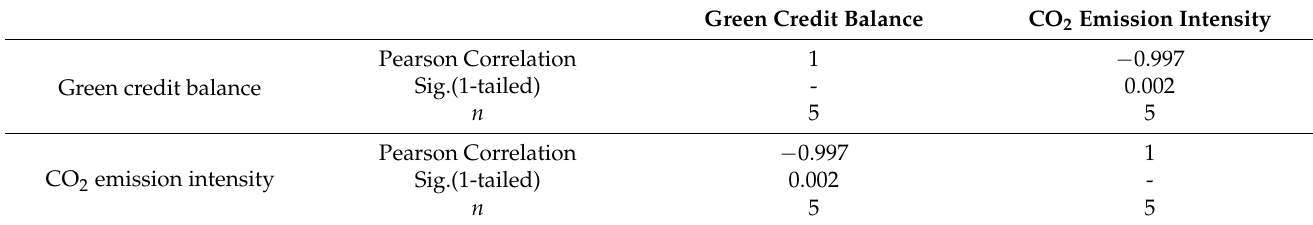
Table 3. Correlation between green credit balance and CO 2 emission intensity.